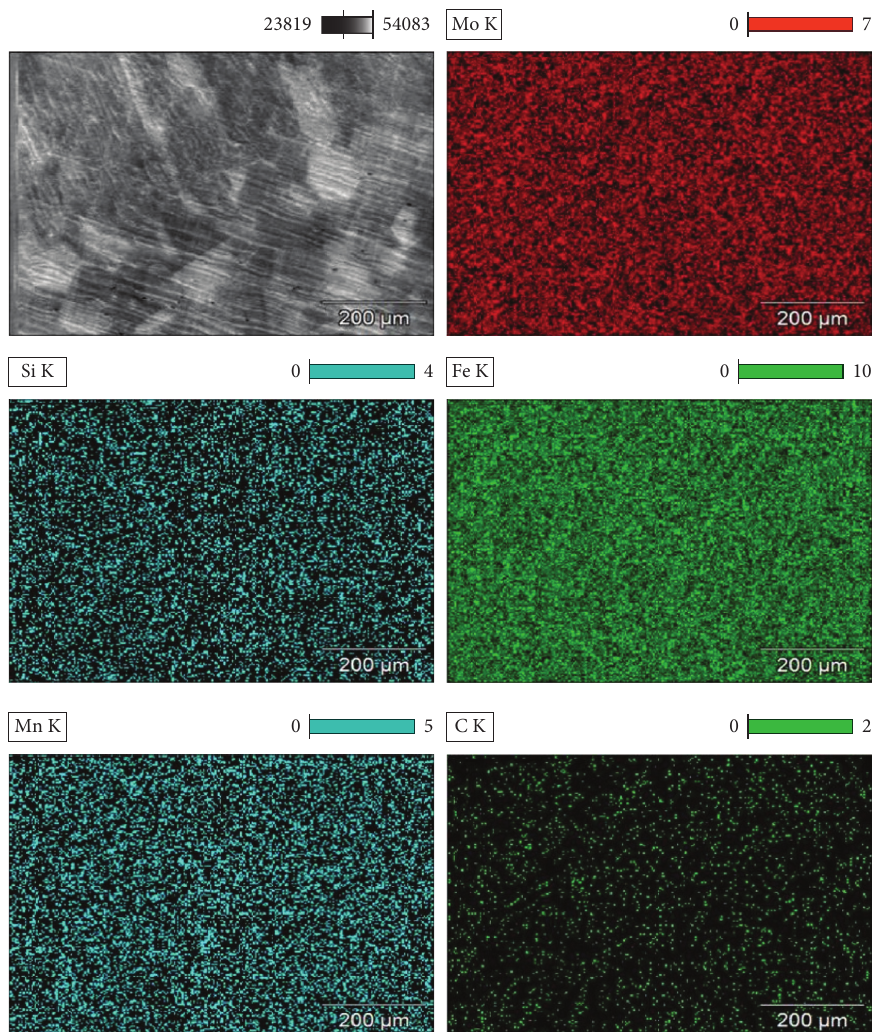
Figure 4: Arrangement picture BSEI and X-ray mapping of the cross portion of uncoated GrA1 steel exposed to electrochemical con- sumption under 3.5%NaCl